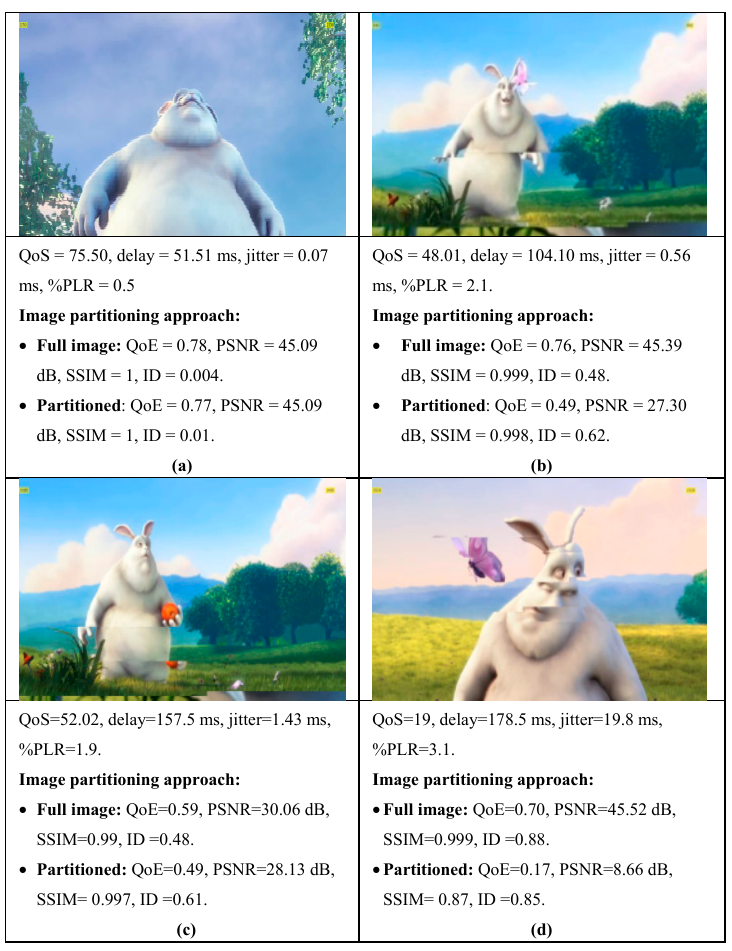
Figure 15. Typical images illustrating the values for QoS, quality of experience (QoE) and the effect of image partitioning on determining quality of received images: ( a ) Time 5 seconds, ( b ) time 43 seconds, ( c ) time 65 seconds and ( d ) 90 seconds.